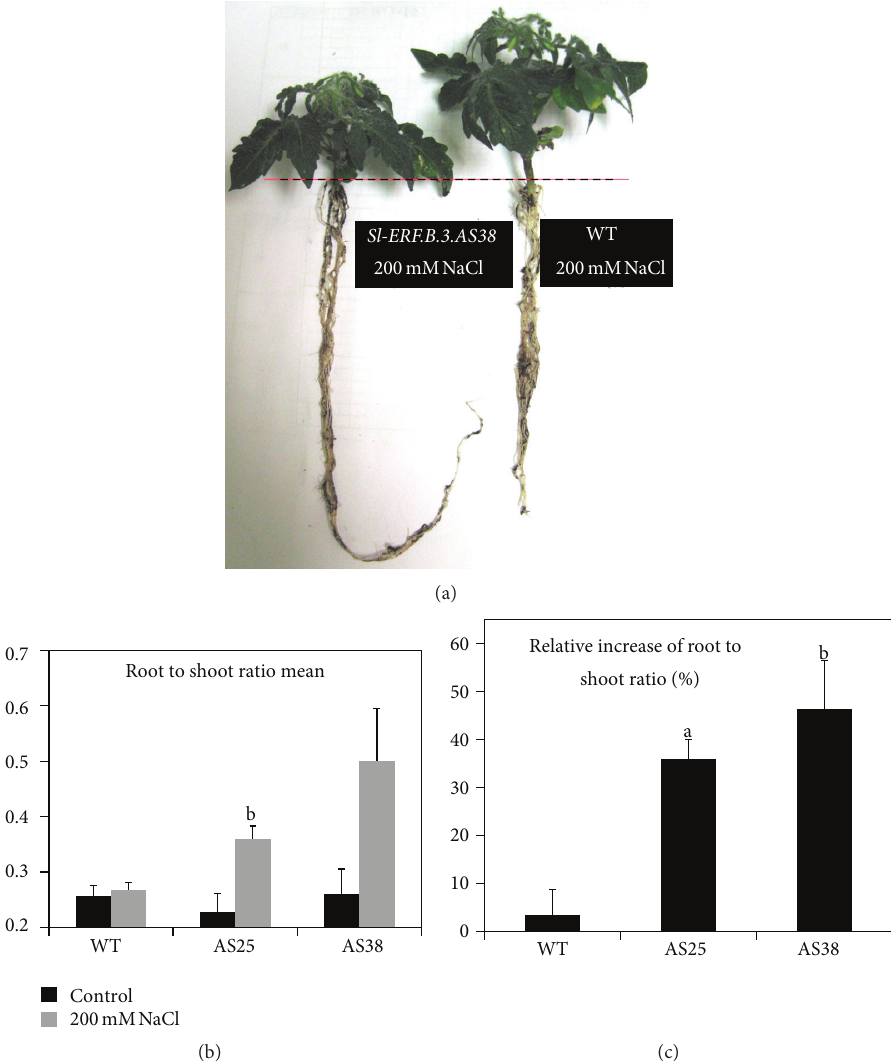
Figure 3: Salt stress effect on root to shoot ratio of Sl-ERF.B.3 antisense transgenic lines (AS25 and AS38) and wild type (WT) tomato plants. (a) Photograph, taken at sampling time after six weeks of salt stress (regular irrigation by 200 mM NaCl solution), shows growth differences between wild type (WT) and Sl-ERF.B.3 -antisense transgenic line (AS38). (b) Variation of root to shoot ratio mean under salt treatment (200 mM NaCl). (c) Relative increase rate of root to shoot ratio in response to sever salt stress treatment in wild type (WT) and Sl-ERF.B.3 antisense transgenic lines (AS25 and AS38). Pairwise comparisons were made between wild type plants and antisense transgenic plants with Student’s 𝑡 -test (a: 𝑃 < 0.05 , b: 𝑃 < 0.01 ). Data represent means and standard error of three